Question: Sum up the contents of this chart in one sentence.
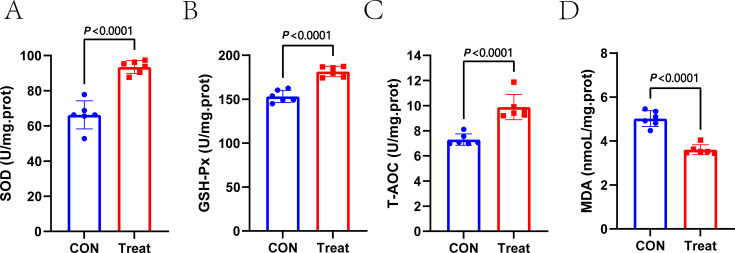
Answer: Effects of supplemental fermented Chinese herbal medicine on duodenal mucosal antioxidant parameters in lambs. Data are presented as mean ± SEM. Group comparisons were analyzed using an independent samples t -test. Bar graphs comparing duodenal antioxidant parameters between control and treated lambs. ( A ) SOD; ( B ) GSH-Px; ( C ) T-AOC; ( D ) MDA. Fermented Chinese herbal medicine significantly increased SOD, GSH-Px, and T-AOC levels and decreased MDA levels.